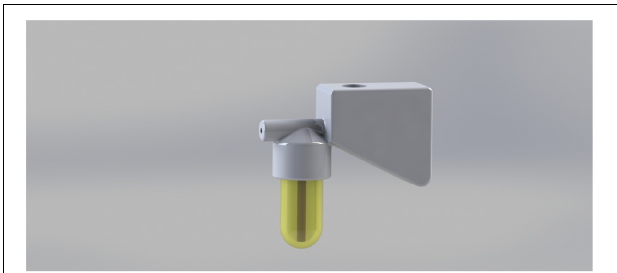
FIGURE 3 | Design of a complete inoculator fitted with a copper tube and containing a gelatin capsule.